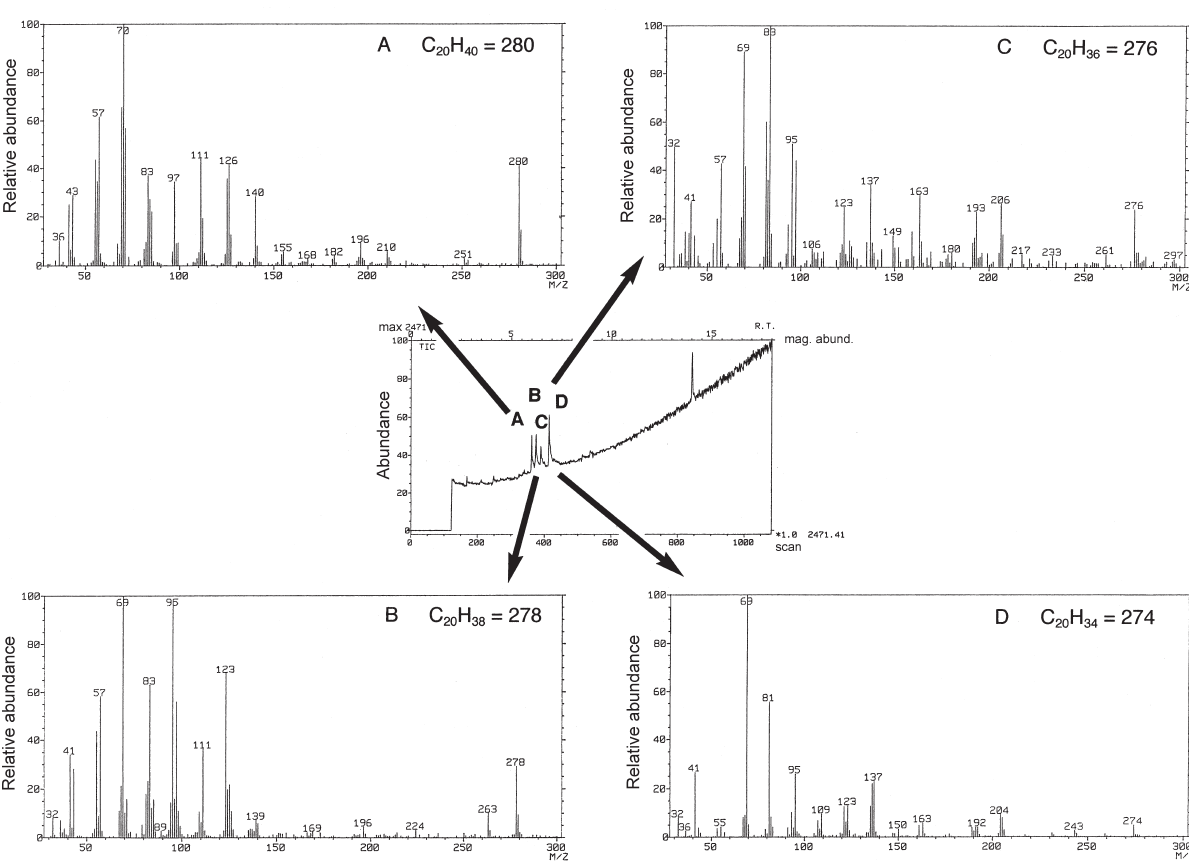
Figure 5. Mass spectra of the LiAlH 4 reductive cleavage products of PL-4. Center panel, TIC chromatogram. Panels A, B, C, and D are mass spec- tra of peaks A, B, C, and D of the TIC